Question: Sum up the contents of this chart in one sentence.
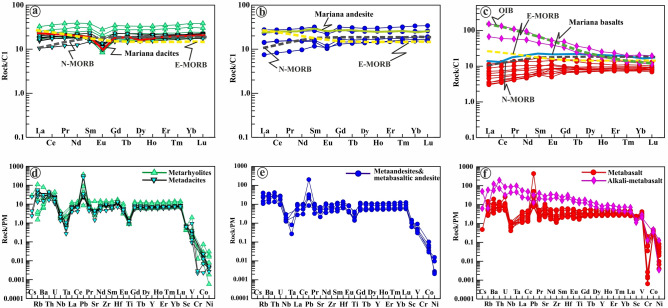
Answer: Trace element compositions of the WRAM. ( a ), ( b ), and ( c ) chondrite (C1)–normalized REE patterns 80 of metarhyolites-metadacites, metaandesites-metabasaltic andesites, and metabasalts & alkali metabasalts; respectively, ( d ), ( e ), and ( f ) PM-normalized trace element patterns 80 of metarhyolites-metadacites, metaandesites-metabasaltic andesites, metabasalts, and alkali metabasalts; respectively. The N-MORB, E-MORB, and OIB patterns are after Sun and McDonough 81 , while the Mariana rocks are after Pearce, et al. 82 . This figure is created by the Igpet 2010 software ( https://www.rockware.com/product/igpet/ ).